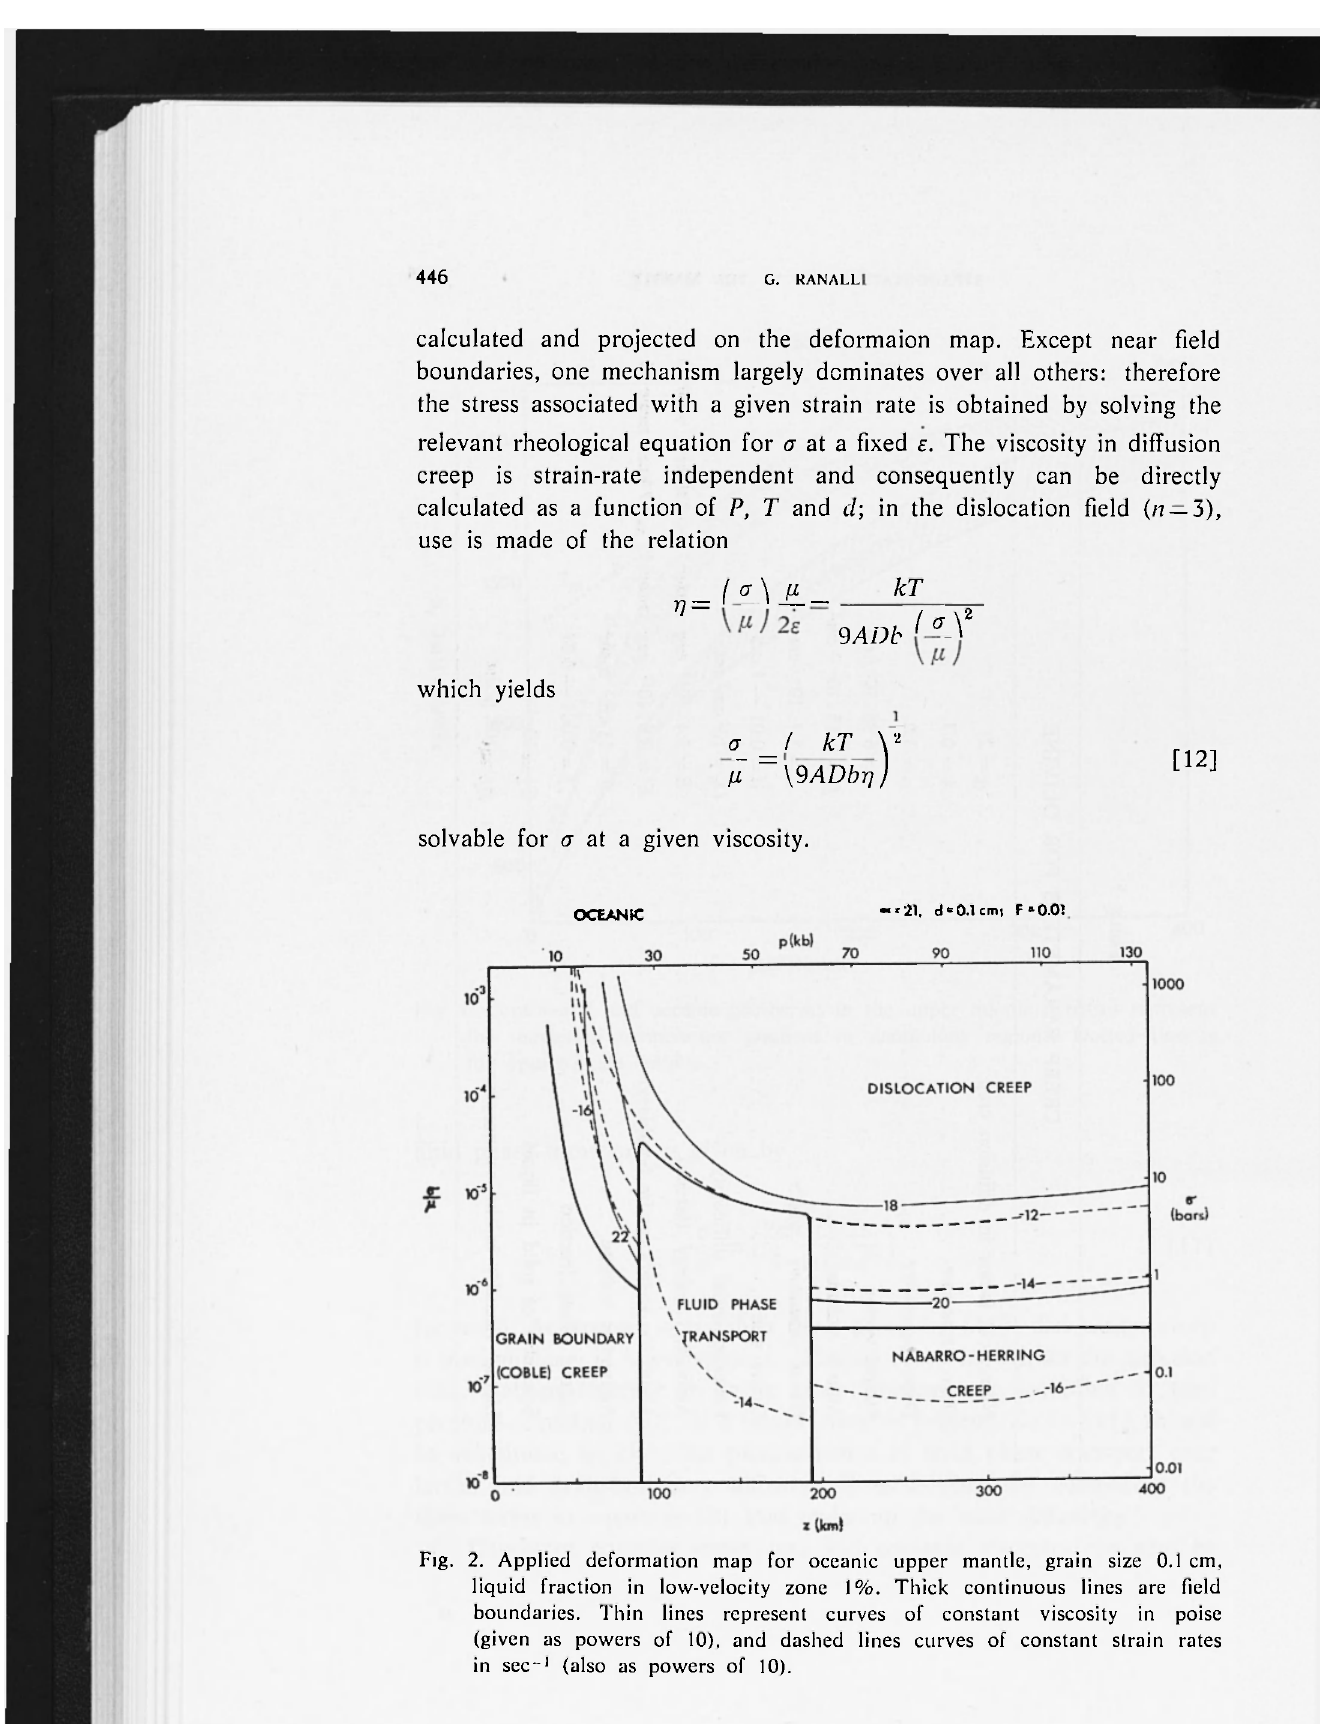
Fig. 2. Applied deformation map for oceanic upper mantle, grain size 0.1 cm, liquid fraction in low-velocity zone 1%. Thick continuous lines are field boundaries. Thin lines represent curves of constant viscosity in poise (given as powers of 10), and dashed lines curves of constant strain rates in sec -1 (also as powers of